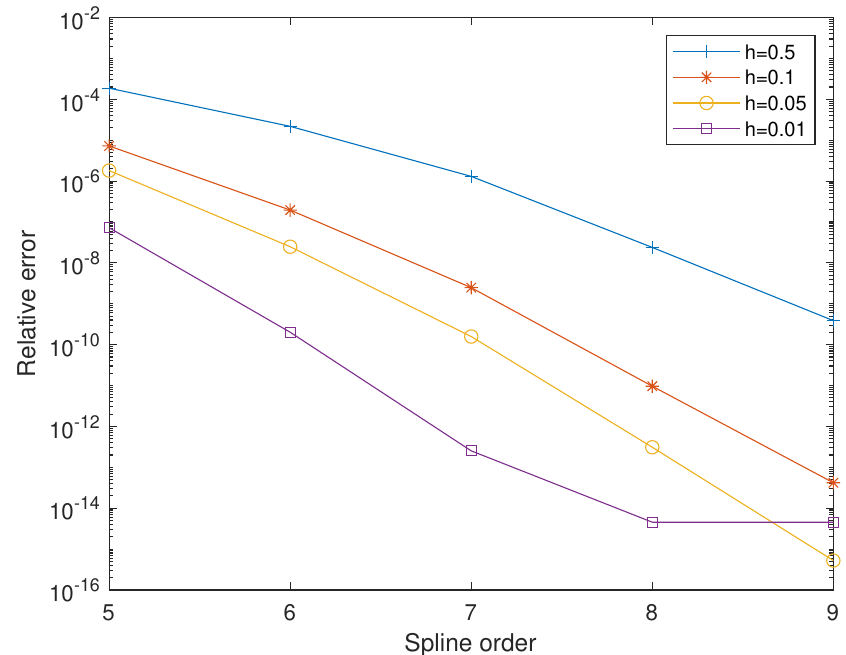
2 for the problem given in Equation (39), for various stepsizes Figure 7. Relative errors at b =